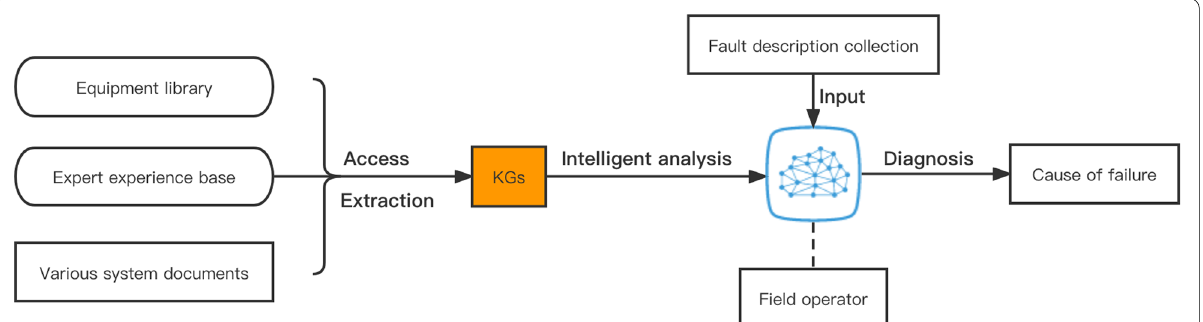
Fig. 1 Schematic diagram of KG construction of power equipment